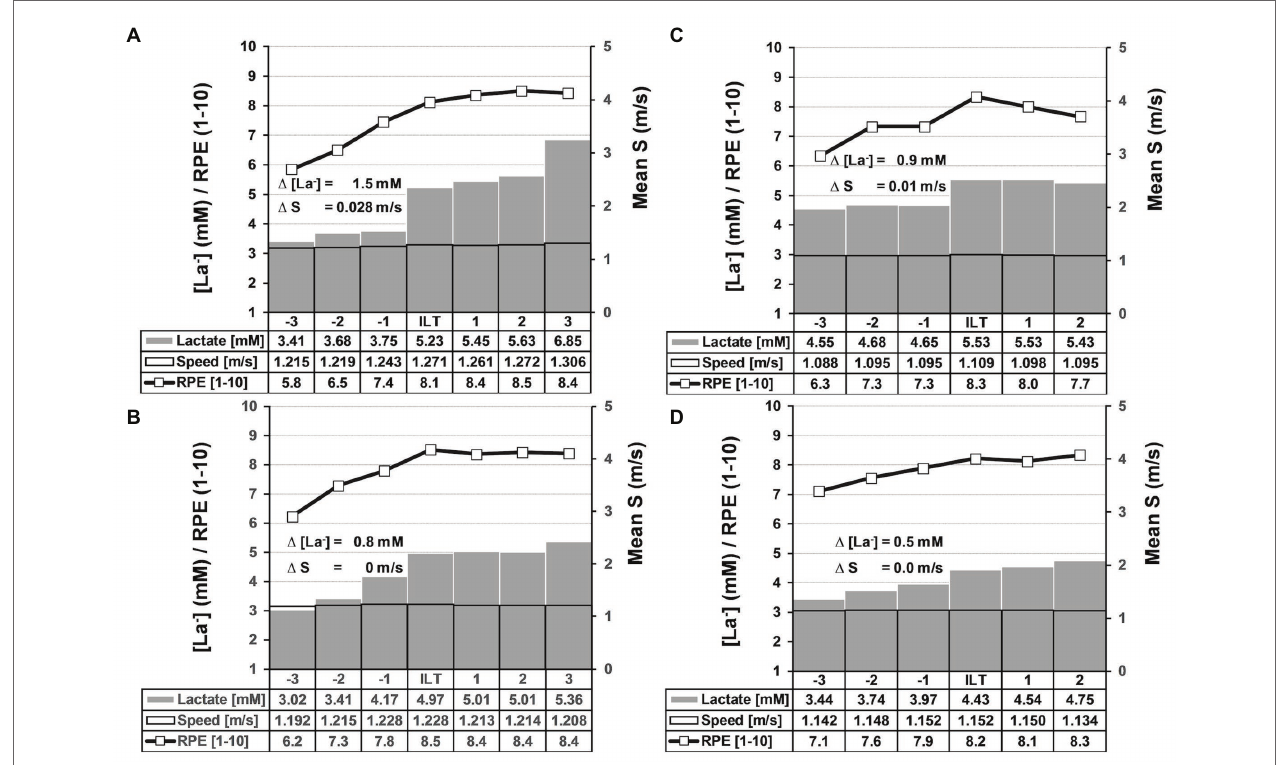
FIGURE 4 | Summary of (individual lactate threshold) ILT-tests and constant speed (CS)-tests. (A,B) Summary of ILT-tests that met threshold criterion 1 ( A , n = 18) or 2 ( B , n = 37). Group mean values are shown for blood lactate concentration (mM), speed (m/s), and RPE (1–10). Note that the step-like lactate accumulation at the ILT in response to a minute increase in swimming speed. (A) Threshold criterion 1: ∆ [La − ] = 1.5 ± 0.237 mM, ∆ S = 0.028 ± 0.003 m/s. (B) Threshold criterion 2: ∆ [La − ] = 0.8 ± 0.065 mM. (C/D) Summary of (CS)-tests that met threshold criterion 1 ( C , n = 4) or 2 ( D , n = 9). Group mean values are shown for blood lactate concentration (mM), Speed (m/s), and RPE (1–10). Note that the step-like lactate accumulation at the ILT in response to a minute increase in swimming